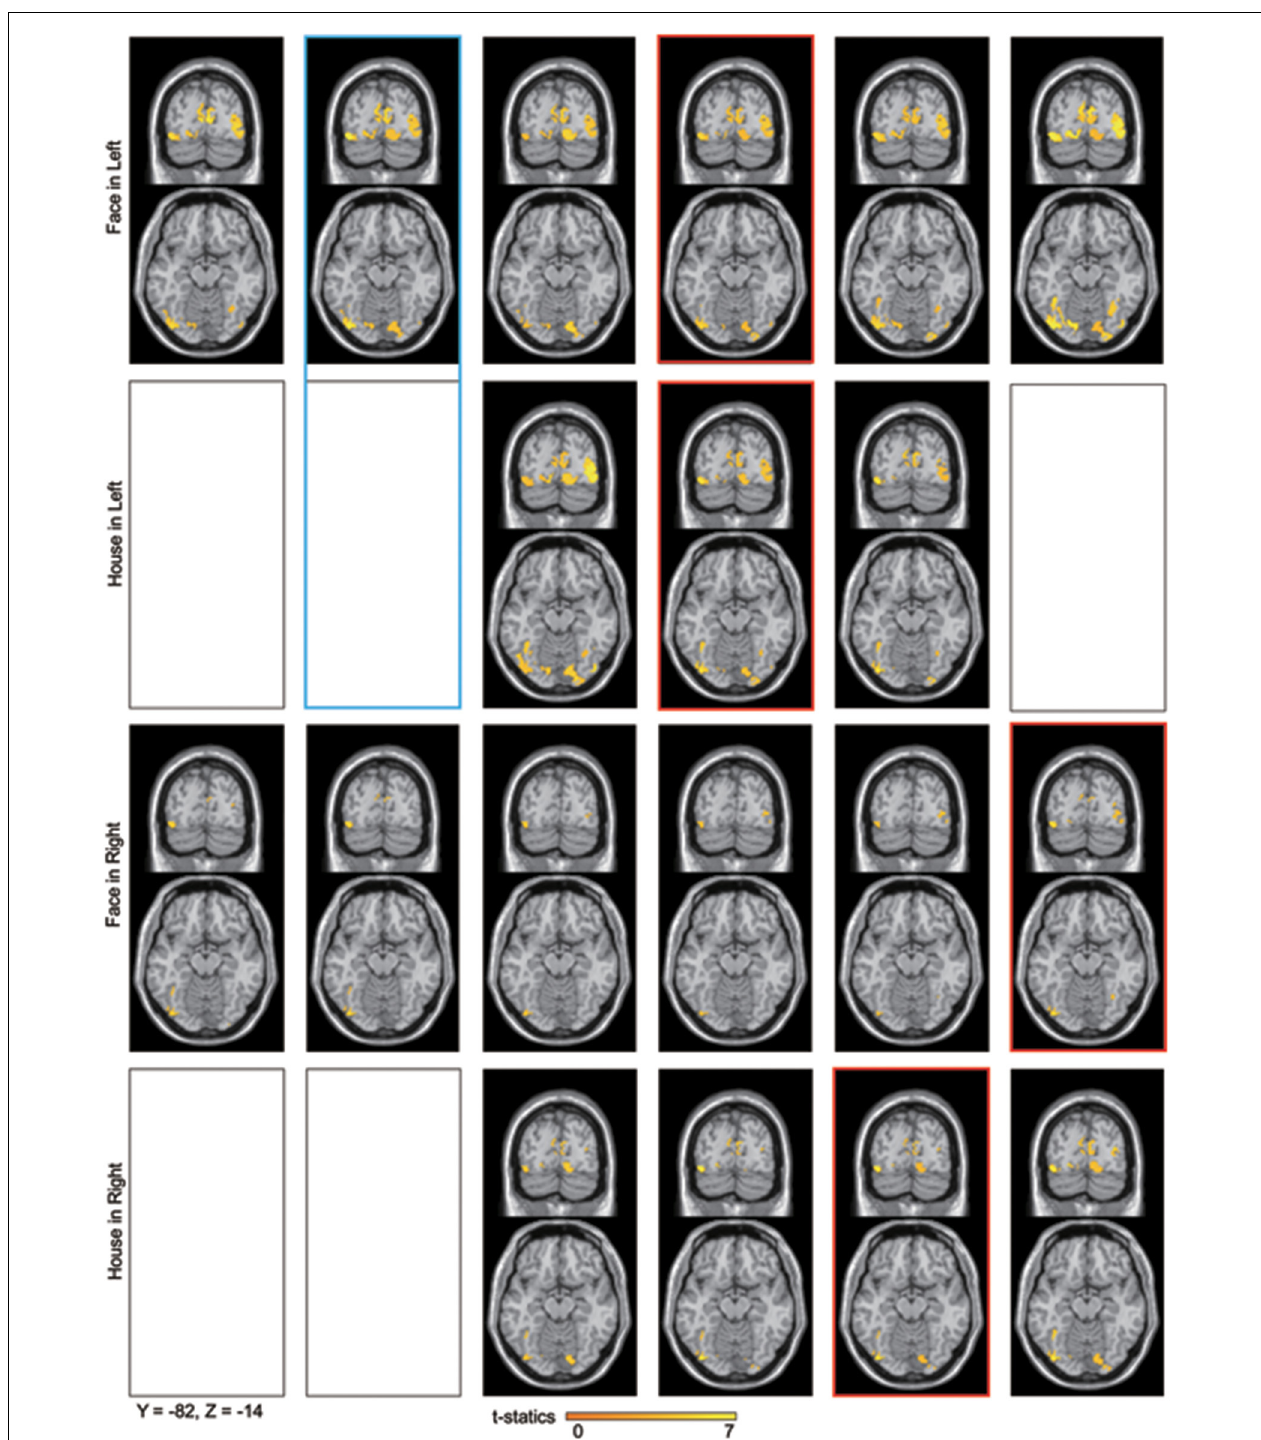
FIGURE 6 | Averaged contour maps across 18 subjects and statistical parametric maps of the estimated source locations of ERFs for group-level analysis along time bins, superimposed on a standard brain image and broken down by stimulus form and display quadrant. Source estimation was performed using MSP during time bins and significant